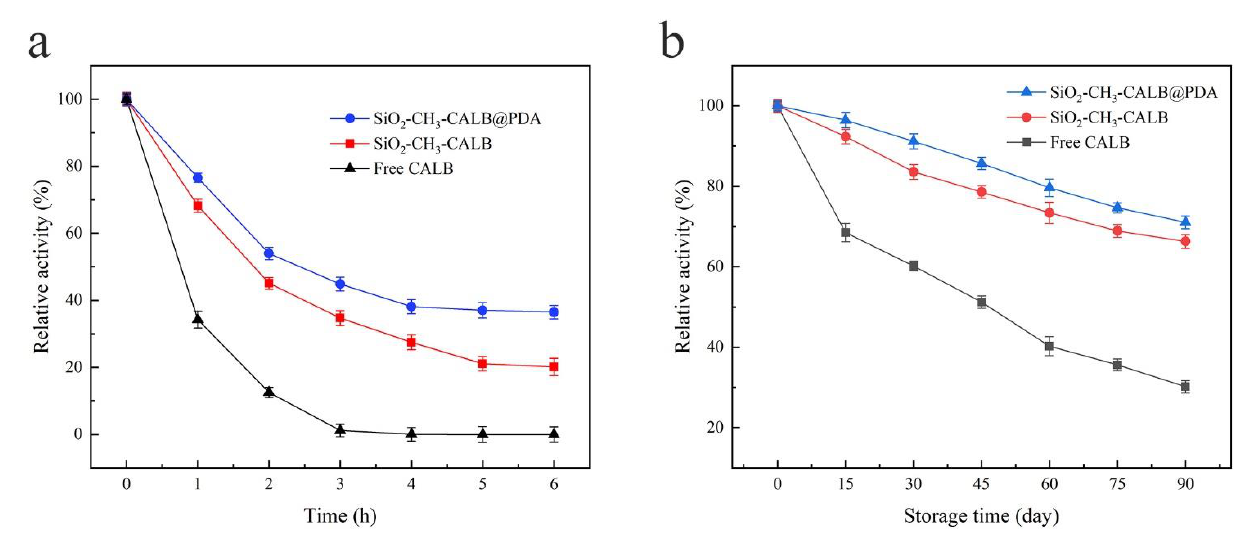
Figure 7. Thermal stability at 60 °C ( a ) and storage stability at 25 °C ( b ) of free CALB, SiO 2 –CH 3 –CALB and SiO 2 –CH 3 –CALB@PDA.